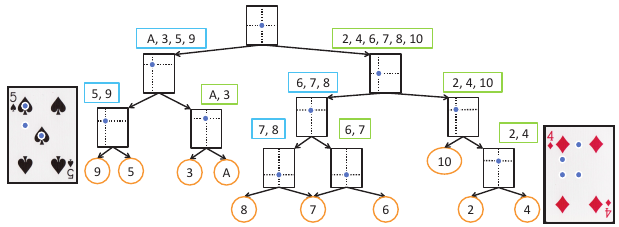
Figure 4. Tree of card number recognition: the system checks blue circles and does not need to check card directions, because cards are vertically symmetric.